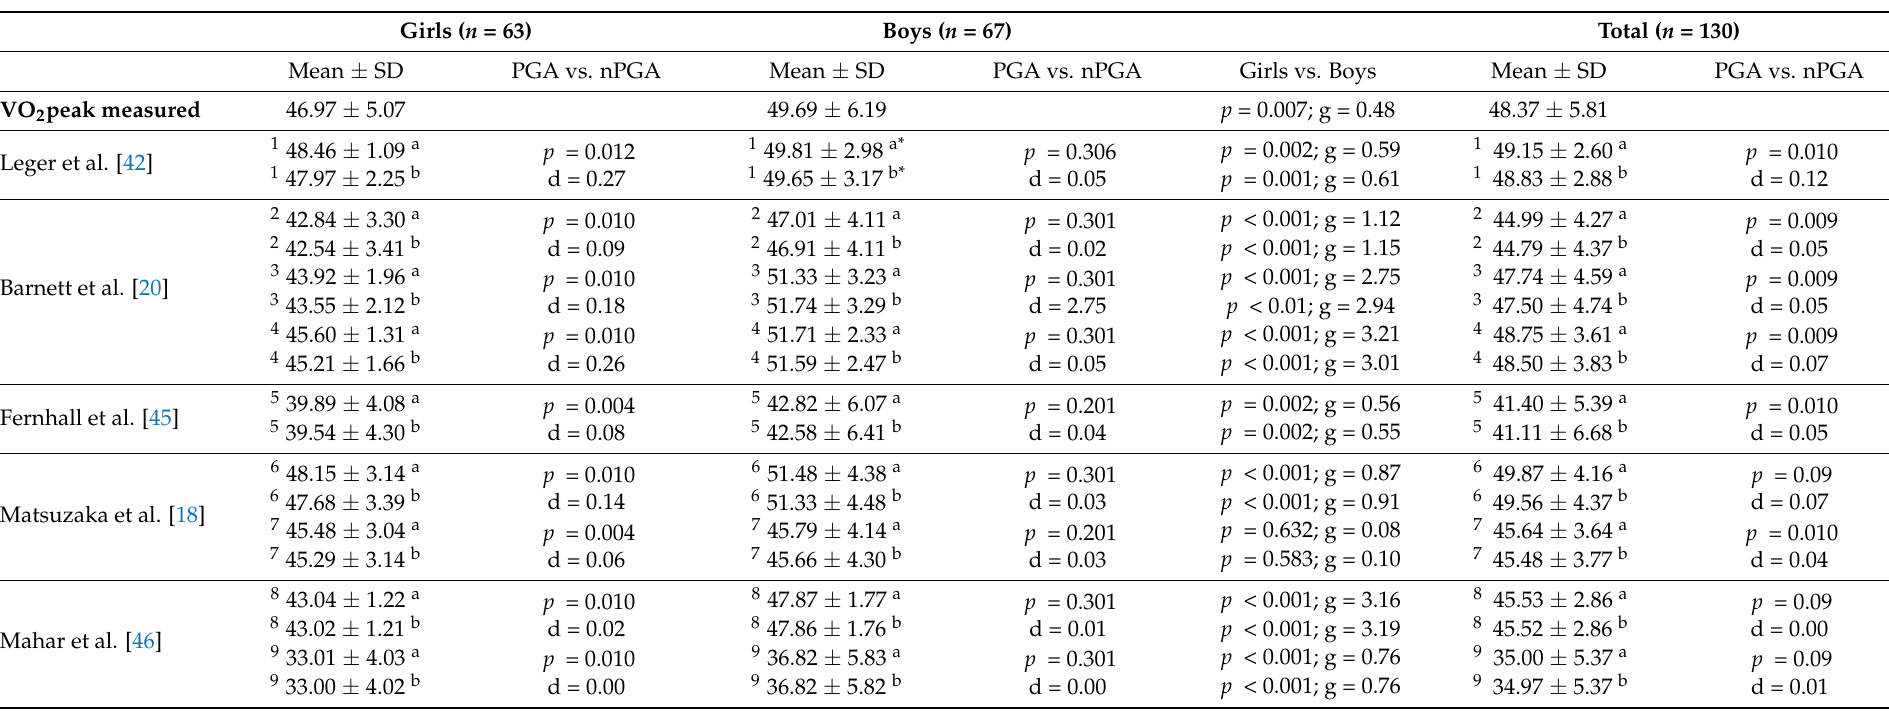
Table 4. VO 2 peak measured and VO 2 peak predicted by equations regarding the total sample and genders during the 20mSRT (mean ± SD in